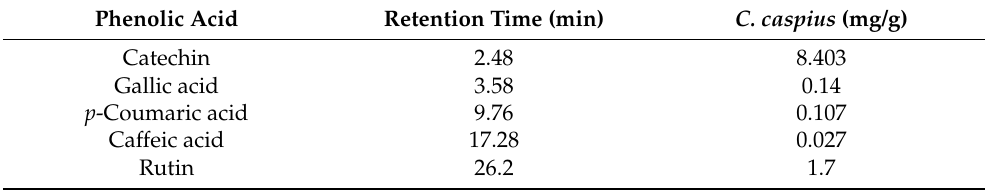
Table 1. The content of some phenolic acids in the extract of C. caspius